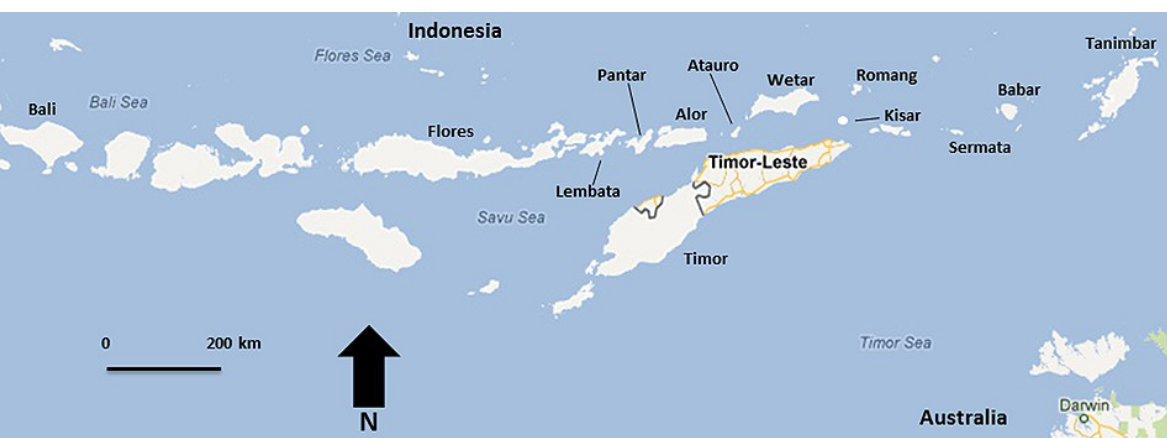
Figure 1. Map of Timor and surrounding Wallacean (Lesser Sunda) islands sampled for this study.